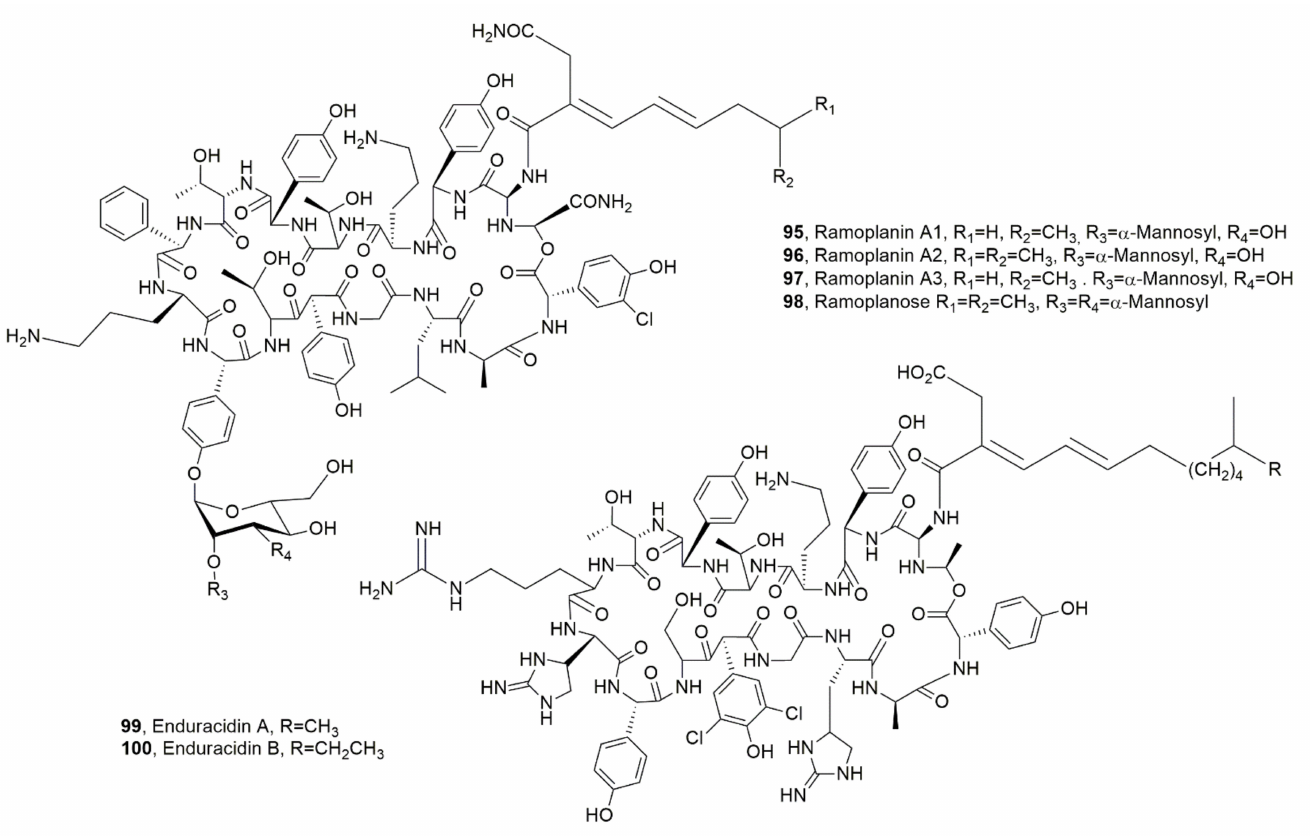
Figure 11. Structures of lipodepsipeptides produced by Actinoplanes ( 95 – 98 ) and Streptomyces fungi- cidicus ( 99 and 100